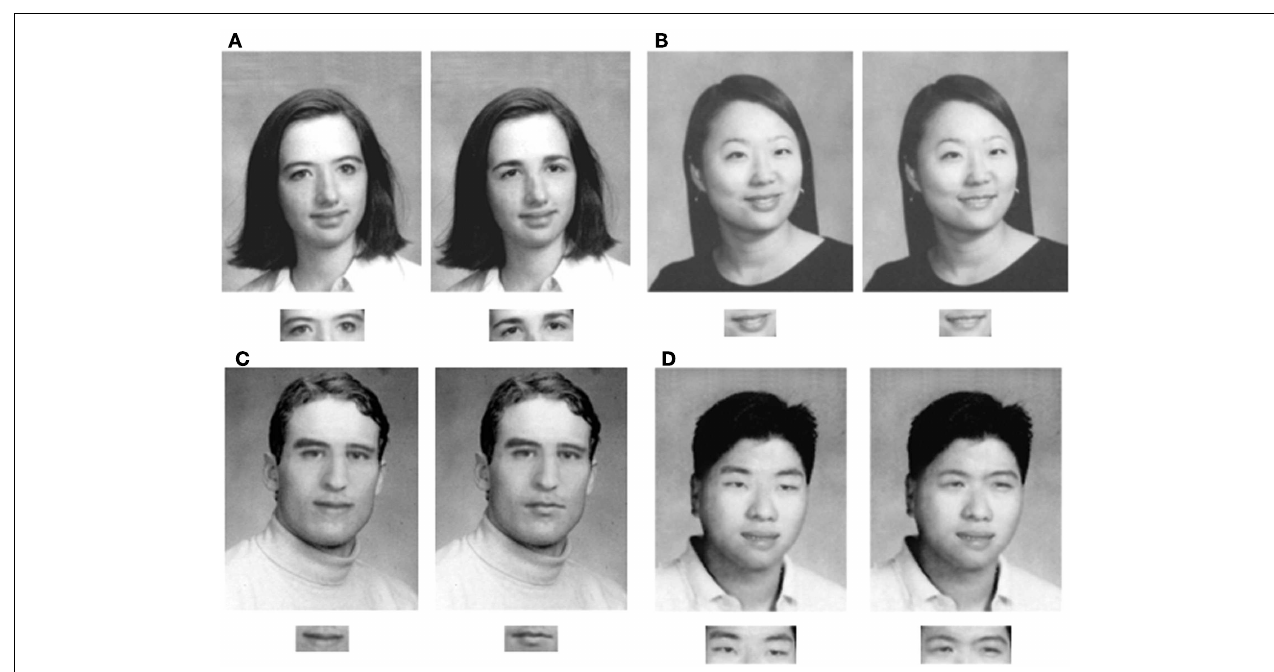
FIGURE 1 | Example whole-face and isolated part test pairs (A) Caucasian female, (B)Asian female, (C) Caucasian male, and (D)Asian male. Whole foil faces differ from the target by only one feature. In the part condition only the critical feature was shown. A whole-face was always shown in the study phase of each